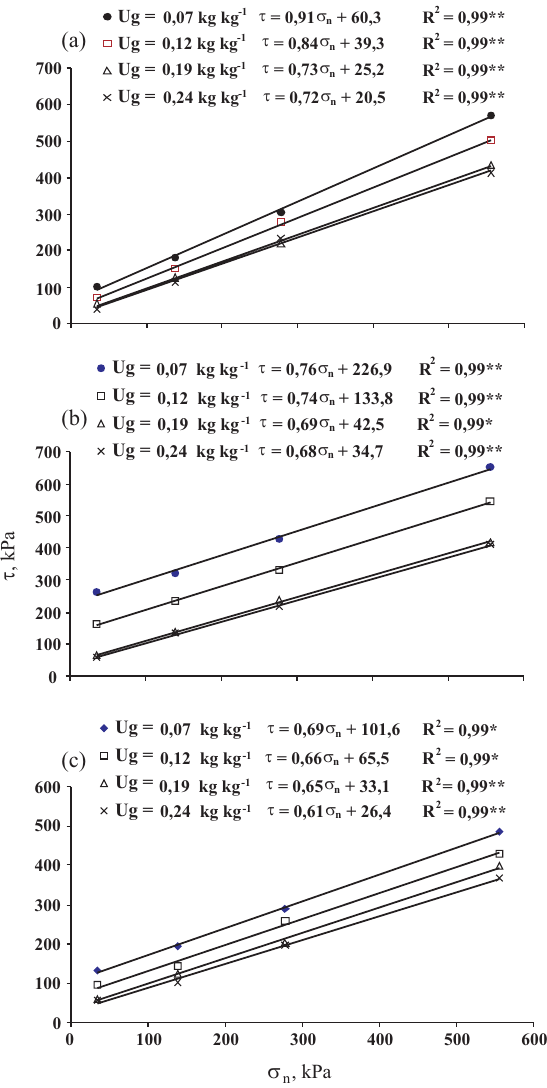
Figura 5. Tensão cisalhante ( τττττ ) como variável da tensão normal ( σσσσσ ) sob diferentes teores de n